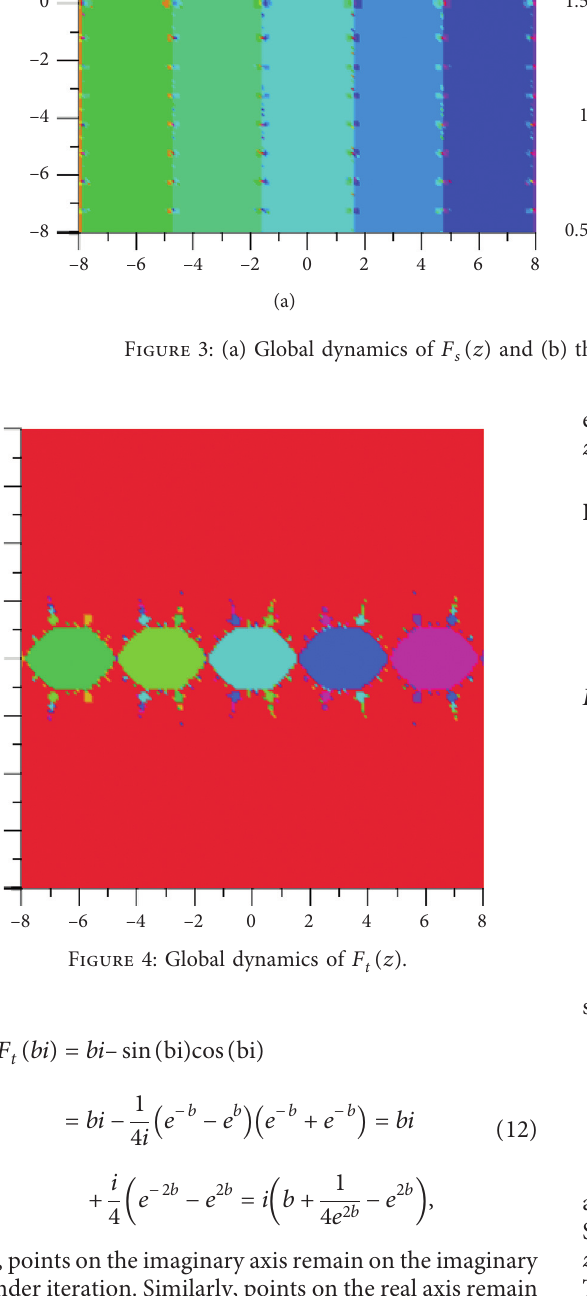
Figure 3: (a) Global dynamics of F